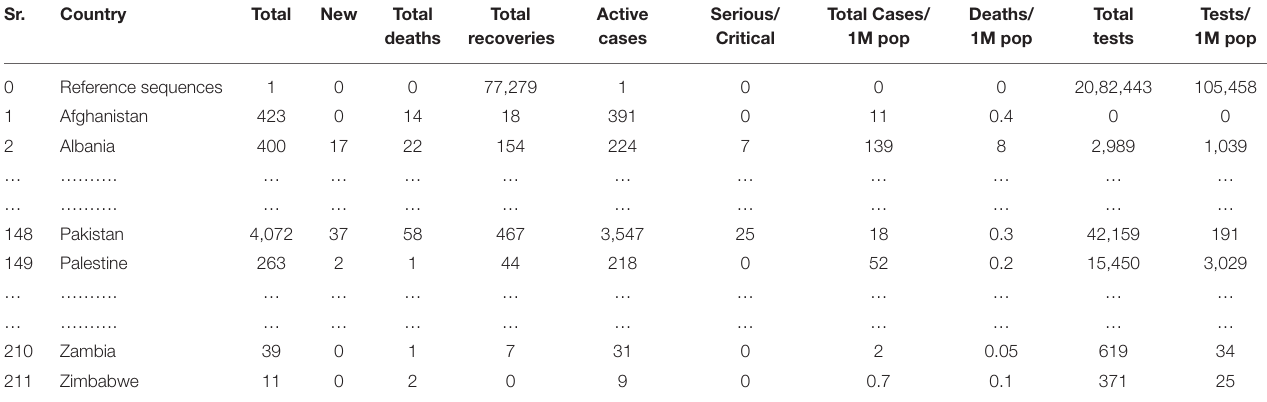
TABLE 3 | Reference sequence and comparable sequences.